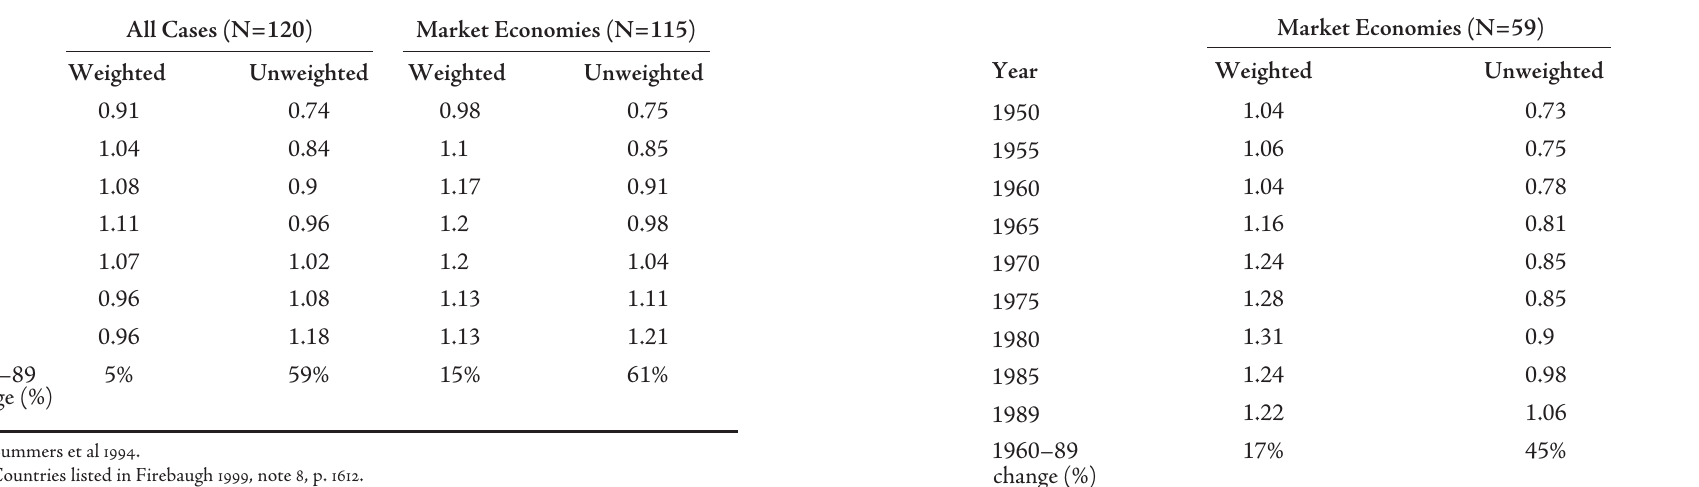
Table 2 – PWT World Income Inequality